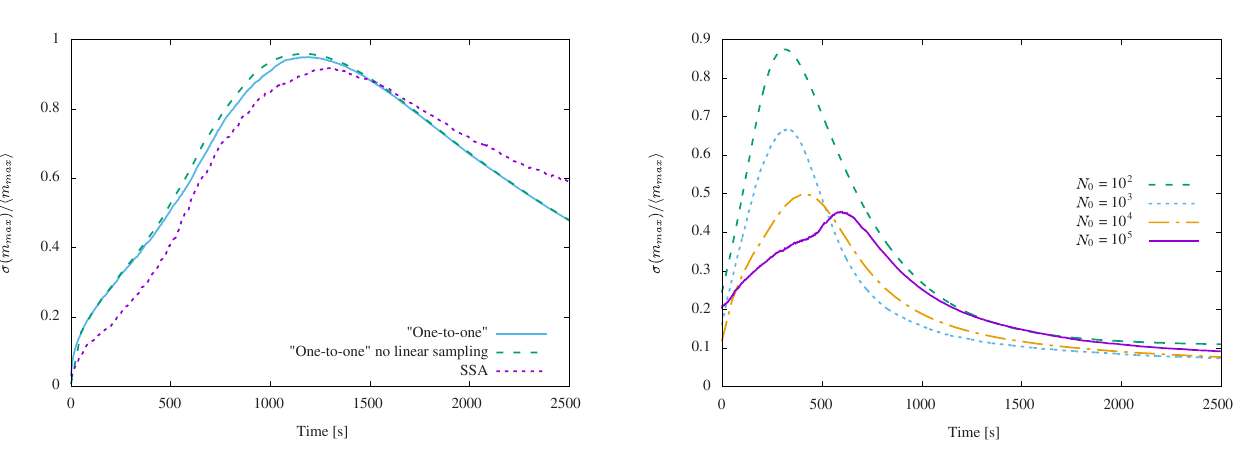
Figure 3. Relative standard deviation of the mass of the largest droplet for different cell sizes. Estimated from ensembles of (cid:127) = 10 4 “one-to-one” simulations for each value of N 0 .